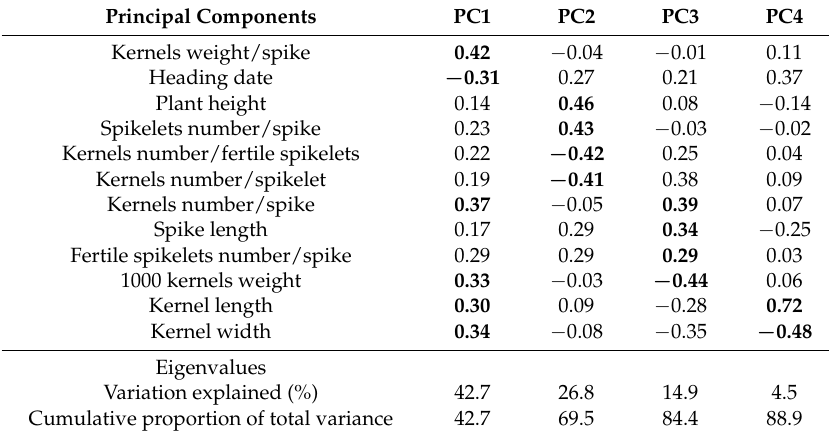
Correlations between four principal components variables and 12 original morphophysiological plant characters for six groups obtained from 136 durum wheat “ex situ” accession and 28